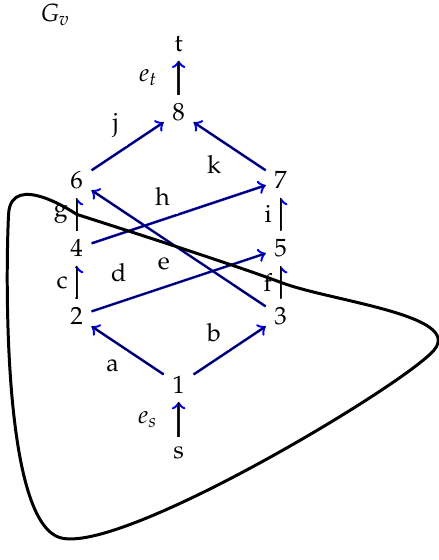
Figure 1. The locations of the studied lakes. Figure 1. A DAG with a vertex cut.